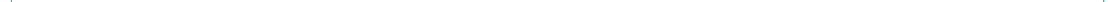
Figure 1: Individual antiretroviral treatment history of vertically HIV-infected children. HIV treatment history over eight years of follow-up is shown. Patients 18 and 21 were analysed by deep sequencing, as described in more detail in the results section, and patient 20 is shown in figure 4. The date of birth is indicated in front of the corresponding time line. Each coloured bar represents a type of treatment. A black bar means no treatment and a grey bar means data not available. Time is represented on the x axis, and the length of a bar corresponds to the in- terval of treatment, including when it was started.3TC = lamivudine; AZT = zidovudine; FTC = emtricitabine; ABC = abacavir; DDI = didano- sine; DDC = zalcitabine; D4T = stavudine; TDF = tenofovir; EFV = efavirenz; ETV = etravirine; DRV = darunavir; LPV = lopinavir; NFV = nelfi- navir; ATV = atazanavir; RTV/r = ritonavir; DTG = dolutegravir; RGV = raltegravir